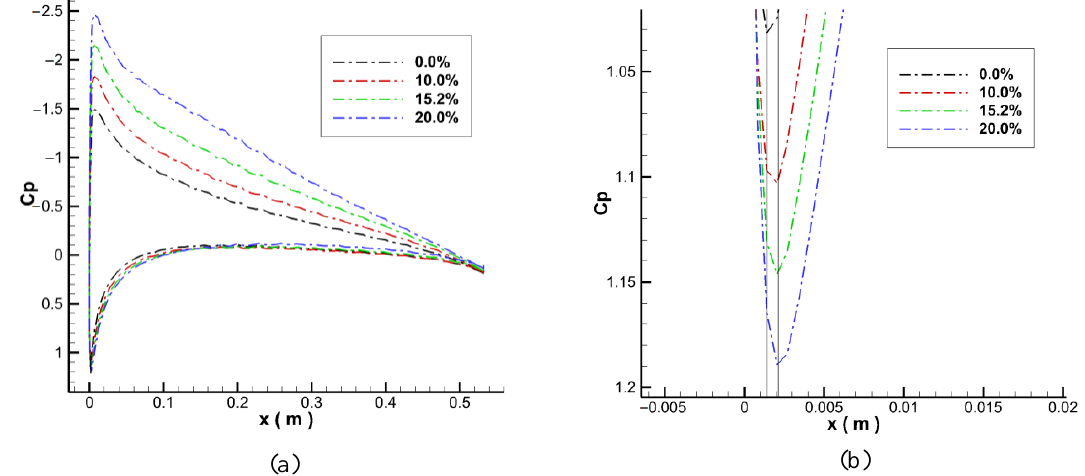
Figure 5. ( a ) Pressure coefficients distribution at different blockages. ( b ) Positions of stagnation point at different blockages.